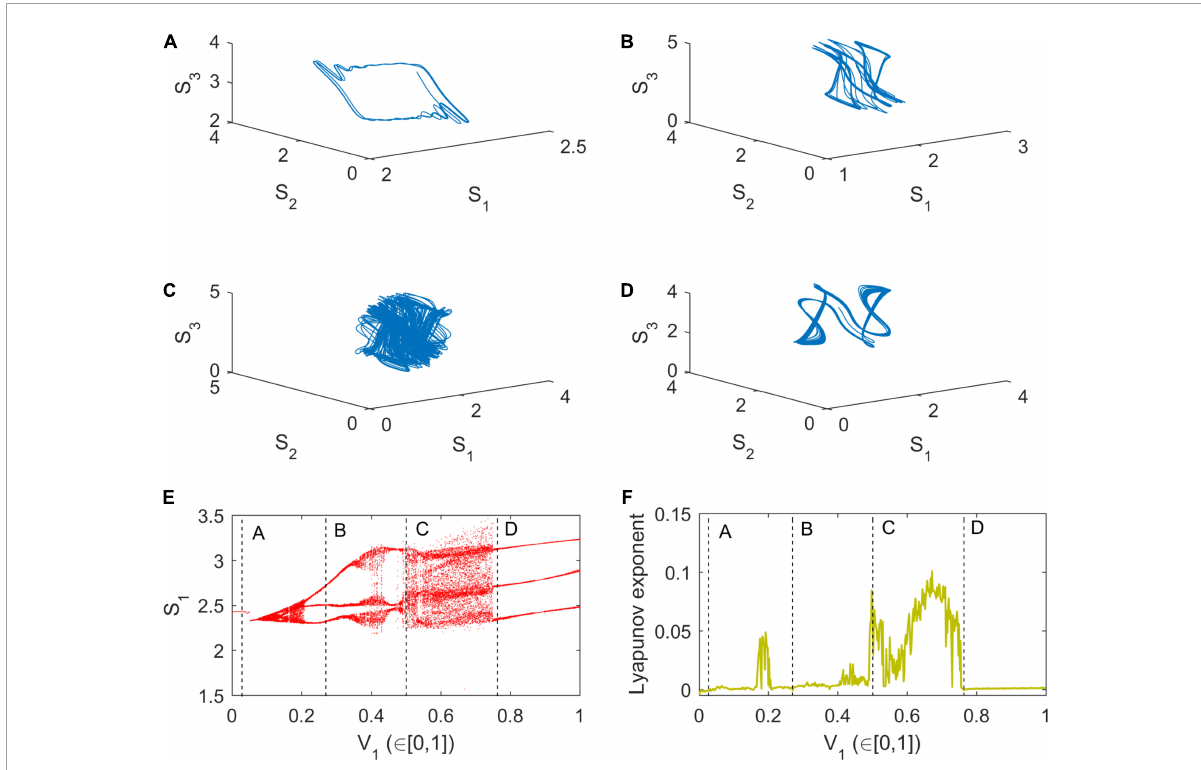
FIGURE2 Eco-evolutionary dynamical simulations. (A–D) Space phase diagrams; (E) Bifurcation diagram; (F) Lyapunov exponent (LE) spectrum. Model parameters are presented in Table 1 and V 1 varies in [0, 1]: Panels (A) V 1 = 0.03, (B) V 1 = 0.27, (C) V 1 = 0.5, and (D) V 1 = 0.764. The simulation time is 1,000 and initial value of Eq. (1) is (0.1, 0.1, 0.03, 0.02, 0.03, 0.01, 0.01, 2.2, 2.4, 2.8, and